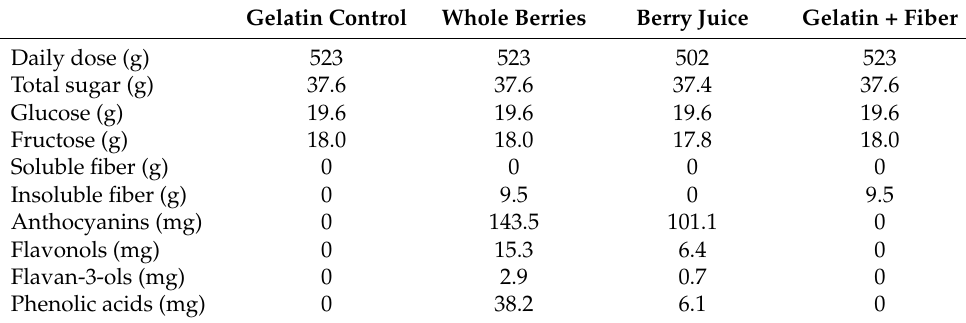
Table 1. Mean daily intake for treatment foods and components 1